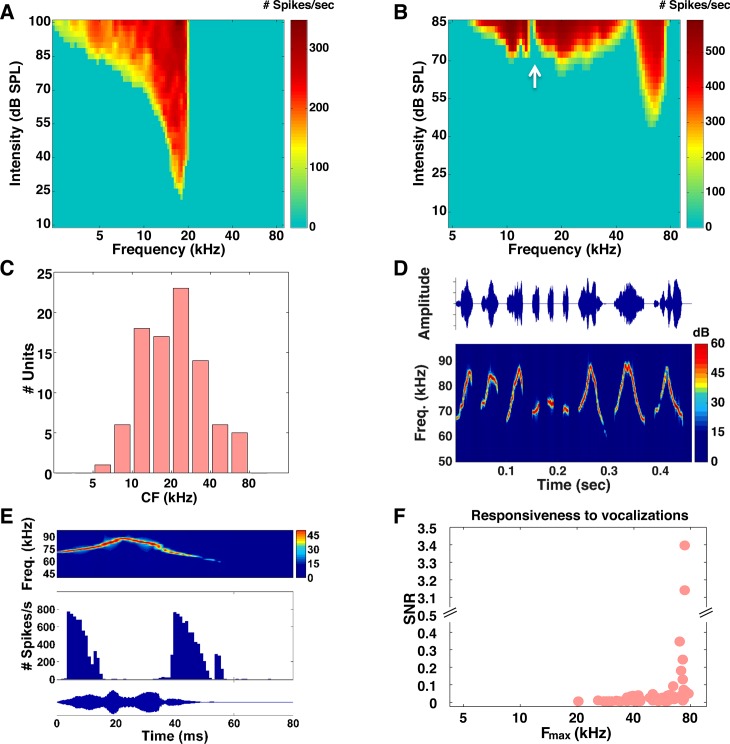
Auditory nerve responses to tones and vocalizations.(A) FRA of a representative auditory nerve fiber. FRAs were constructed from the responses elicited by tones of varying frequency (x-axis) and intensity (y-axis). (B) FRA of one AN fiber that was responsive to high frequency tones. The white arrow marks the location of a spectral notch created by the pinna. (C) Histogram of the distribution of CFs across the population of AN fibers. (D) Sound pressure waveforms (top panel) and spectrograms (lower panel) for the nine different CBA/Ca mouse vocalizations we tested. Note that all the vocalizations span a frequency range from 60–90 kHz. (E) PSTH of the response of the same fiber to a single mouse vocalization with a duration of 60 ms and averaged over 256 repeats. The spectrogram and sound pressure waveforms are shown at the top and bottom panels respectively. (F) Responsiveness to vocalizations. Each point indicates the SNR for one fiber as a function of the highest frequency for which its responses to tones were significantly greater than its spontaneous activity (Fmax). SNR values were averaged across the 9 different calls we tested.